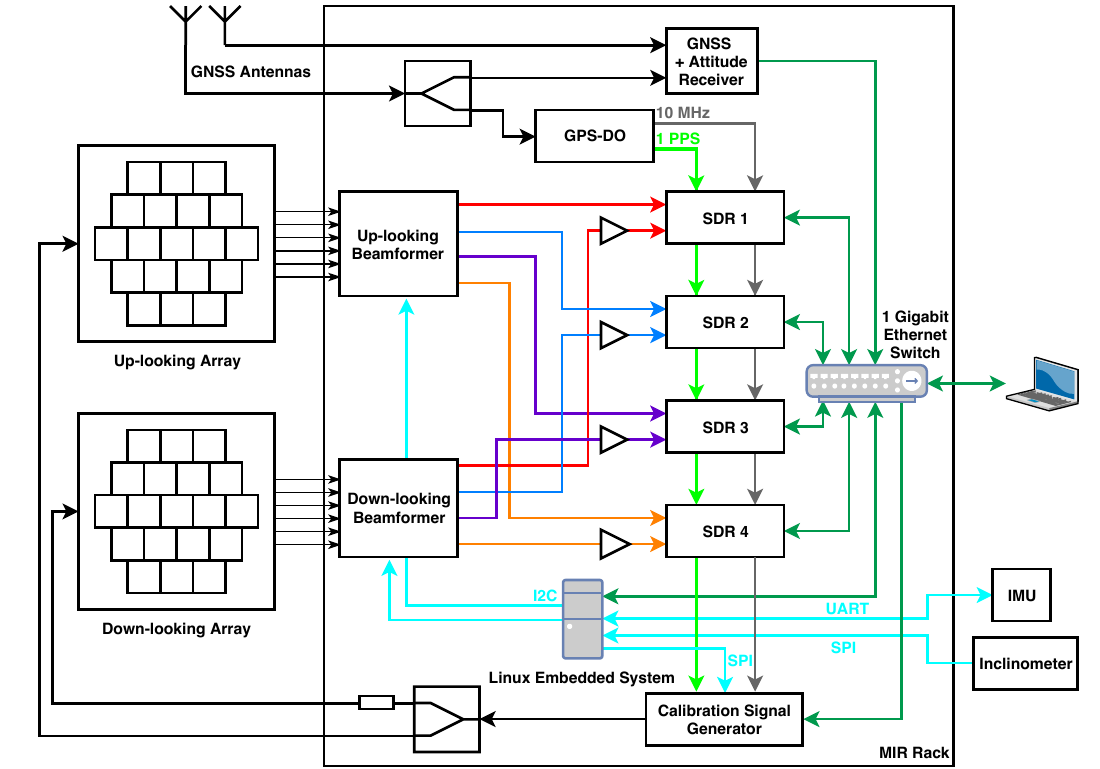
Figure 1. Block diagram of the MIR instrument. The red, blue, orange, and purple lines correspond to the radio frequency (RF) signals of each of the four beams from both the up- and the down-looking array. The light green is a 1 Pulse Per Second (PPS) signal. The grey line is a 10 MHz reference signal. The cyan lines correspond to serial protocols of communication, such as Inter-Integrated Circuit (I2C), Serial Peripheral Interface (SPI) or Universal Asynchronous Receiver-Transmitter (UART). The dark green lines are Ethernet lines. The black lines are other radio frequency (RF) signals, such as the calibration signals, or the GNSS signals for the GNSS receiver. SDR stands for Software Defined Radio. IMU stands for Inertial Measurement Unit. GPS-DO stands for GPS—Disciplined Oscillator.